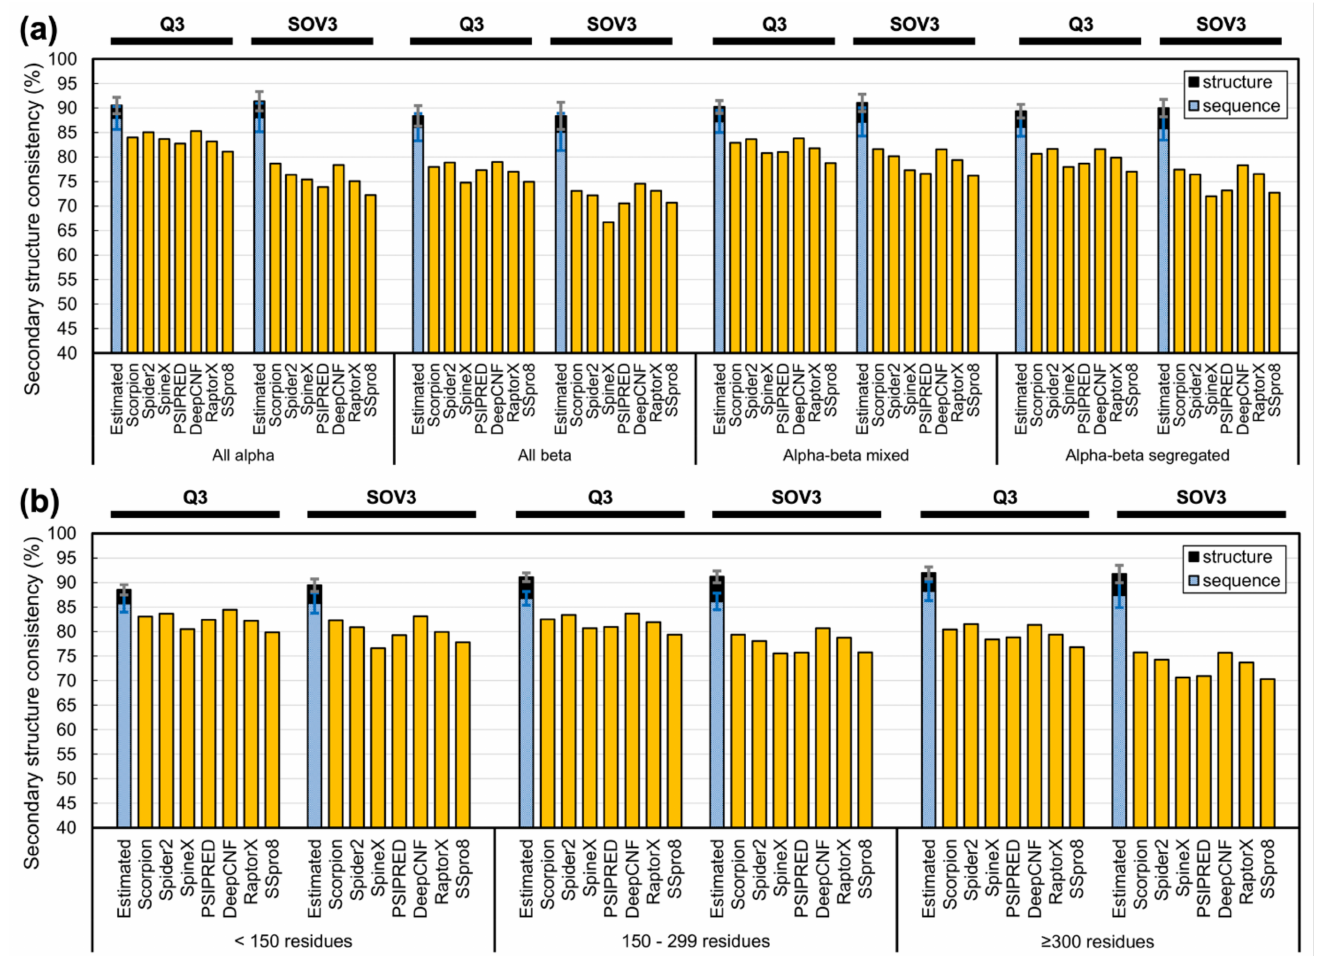
Figure 8. Accuracy of state-of-the-art SSP methods for proteins of different ( a ) structural classes or ( b ) sizes. The upper limit of SSP accuracy estimated by sequence and structural alignments at 90% identity cutoff of homologs are respectively indicated by blue and black bars. No method exceeded the estimated limits in any class or size group, and most methods met the greatest challenge in predicting all-beta proteins. SSP accuracy decreased a little as the protein size increased. Since the same tendencies were observed in three- and eight-state predictions, this figure only displays Q3 and SOV3. See Figure S1 for Q8 and SOV8